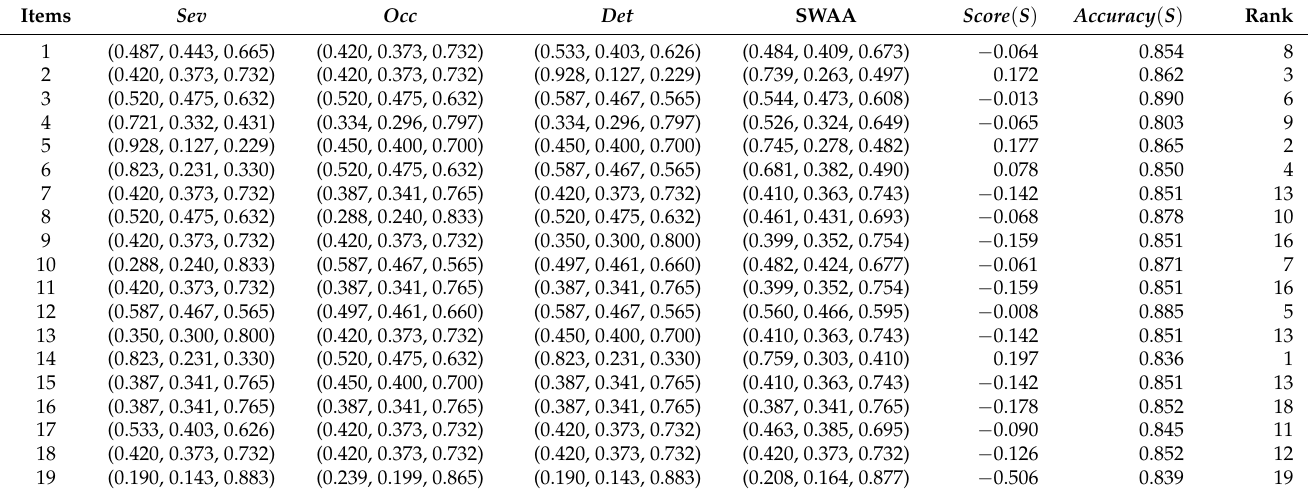
Table 6. The SWAA, score, and accuracy values of the electronic equipment new product design